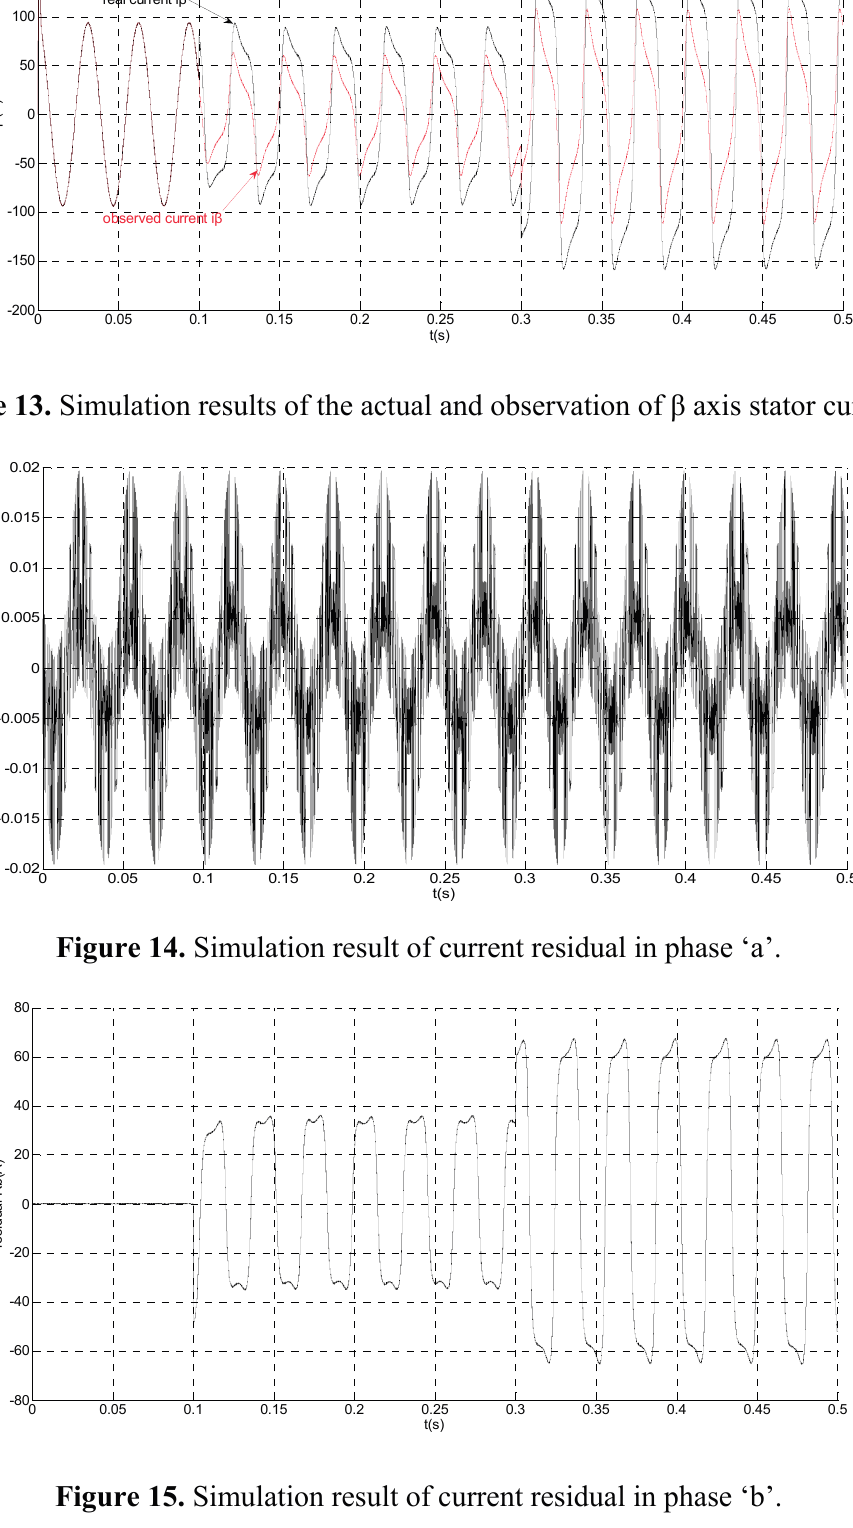
Figure 15. Simulation result of current residual in phase